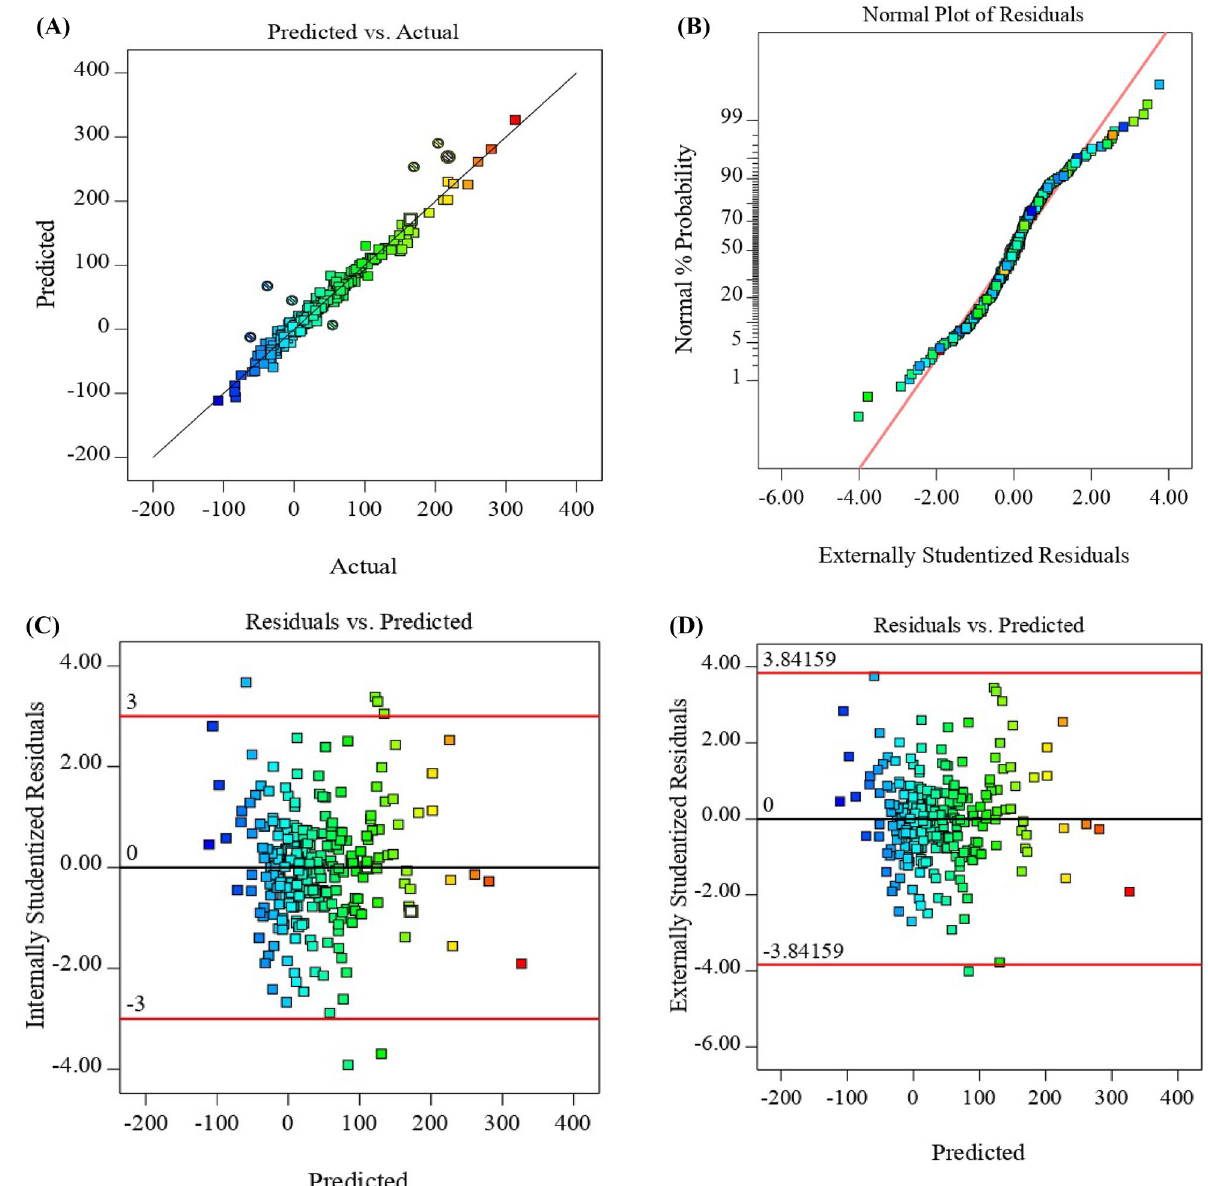
Figure 3. The CCD Predicted value of mass transfer flux; ( A ) actual absorption vs. predicted, ( B ) externally studentized residuals vs. normal plot ( C ) predicted vs. internally studentized residuals, and ( D ) predicted vs. externally studentized